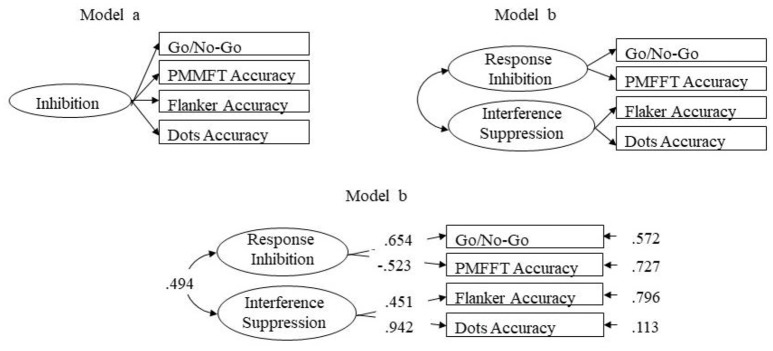
Inhibition models. Model b is the endorsed model (standardized parameters are reported).